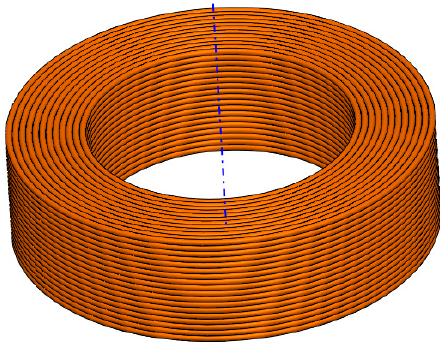
Figure 6. Detailed model of the filter considering the real geometry of the winding.